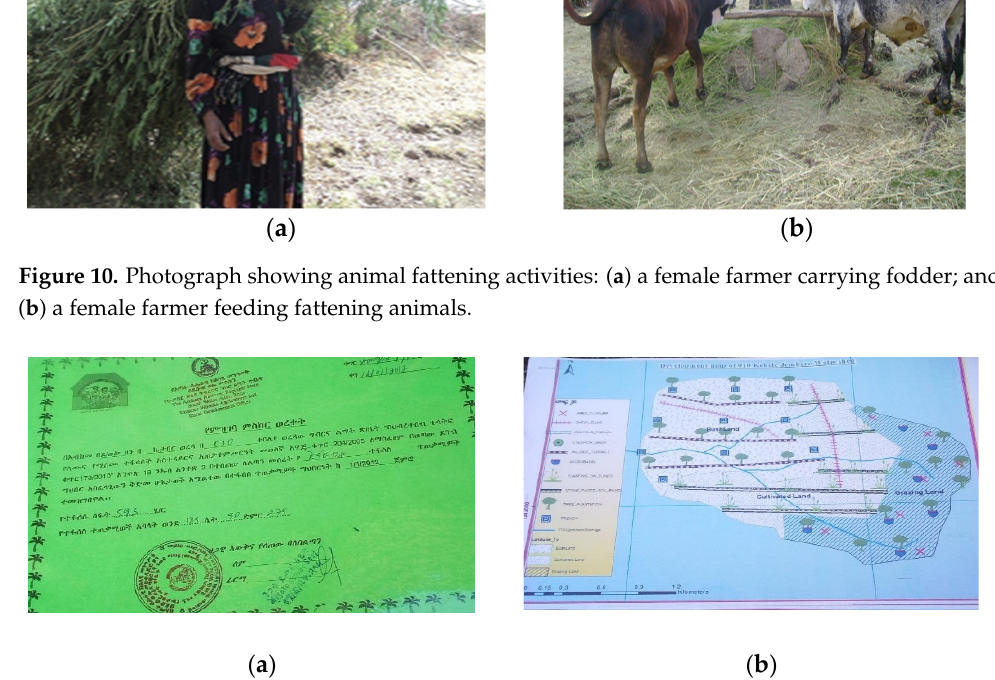
Figure 12. ( a ) Stone-faced bund covered with unpalatable plant species; and ( b ) broken and unmain- tained bund on-farm plot.